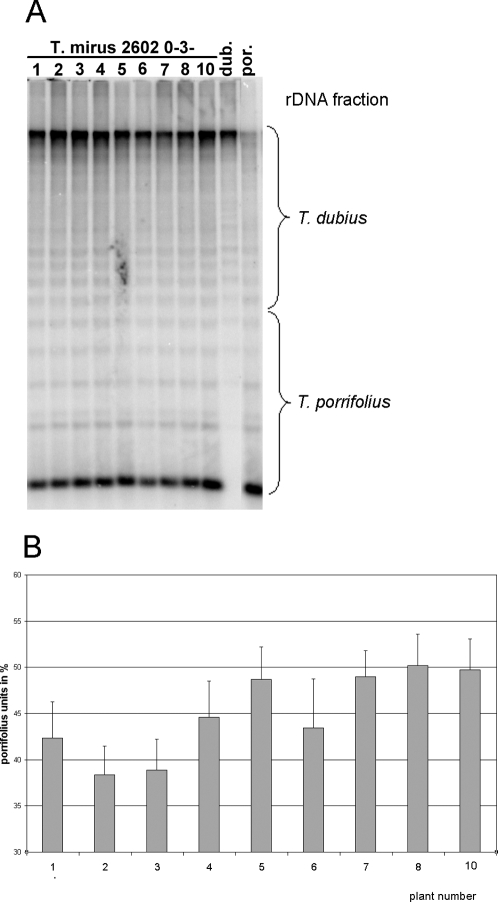
Genomic analysis of 5S rDNA repeats.(A) Southern blot hybridisation of 5S rDNA probe to TaqI-digested genomic DNA of the progeny of 2602-0-3 individual and diploid parental accessions. (B) Quantitative representation of the parental 5S gene families determined by a phosphorimager scanning of radioactivity signals on blots (three independent experiments).